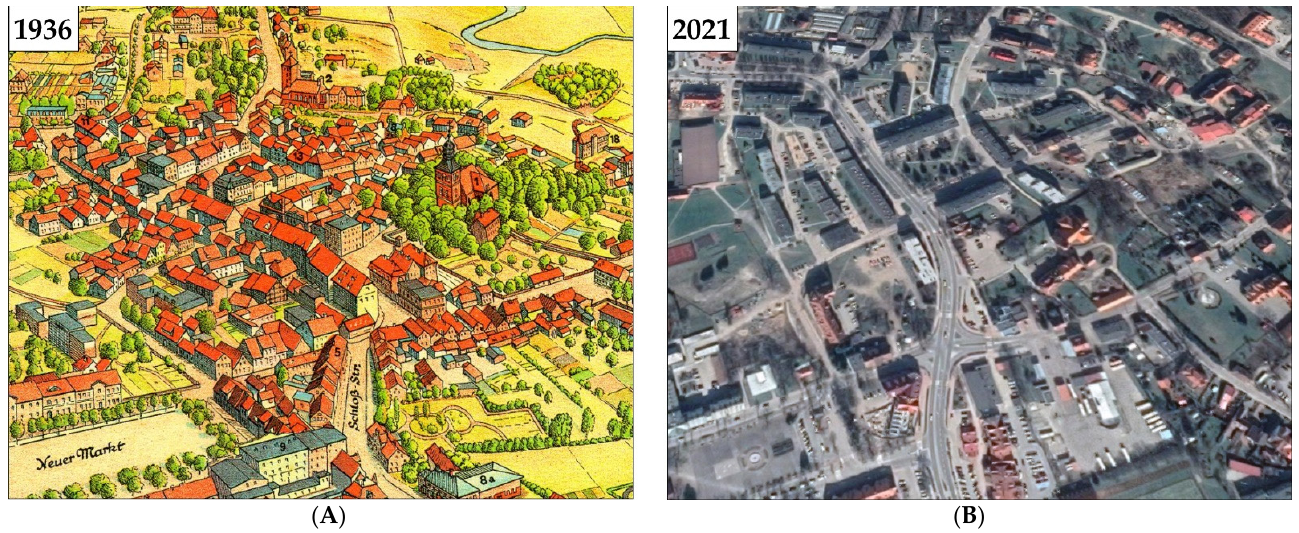
Figure 1. ( A ) Land use in W ę gorzewo in 2020; ( B ) the location of W ę gorzewo within present administrative and political borders; and ( C ) the location of W ę gorzewo within historical and political borders (1939). Source: ( A ), ( B ) and ( C ) own study; ( A ) using the Topographic Objects Database BDOT [68].